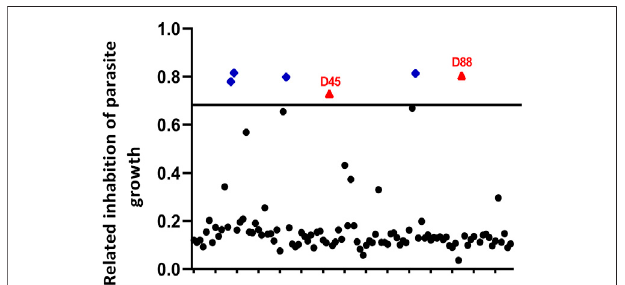
FIGURE 1 | Primary small-molecule screening of different compounds that show anti- Toxoplasma gondii activity and less cytotoxicity. Human foreskin fi broblast (HFF) cellsinfected with RH-2Fwere cultured with10 μ Mof each compound for 72 h, and then parasite growth was detected by β - Gal activity. The dimethyl sulfoxide (DMSO) group was used as negative control group to calculate the inhibition rate. In addition, among the compounds that inhibited parasite growth more than 70%, we screened the compounds with less cytotoxicity ( ≥ 80% cell viability). Red triangles, no host cell toxicity (D45 refers to estradiol benzoate; D88 refers to octyl gallate); blue diamonds, host cell toxicity; black circles, less than 70% parasite